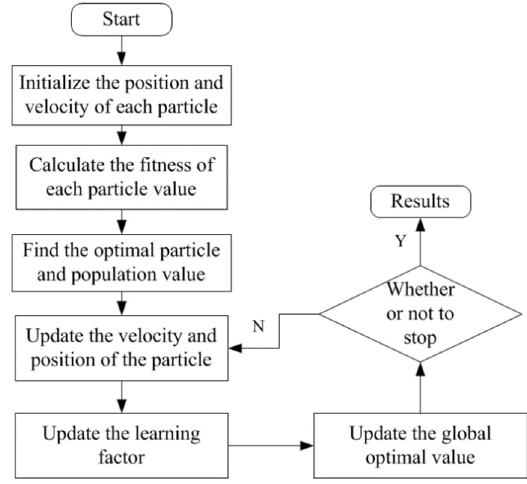
Figure 10. Improved PSO flow chart.